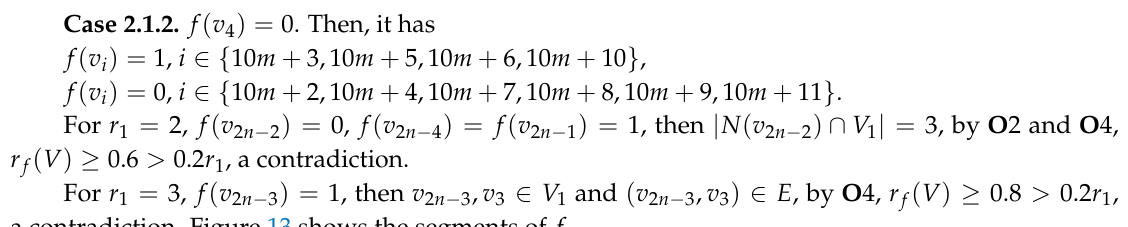
Figure 12. Segment of f in Case 2.1.1 in Lemma 8.